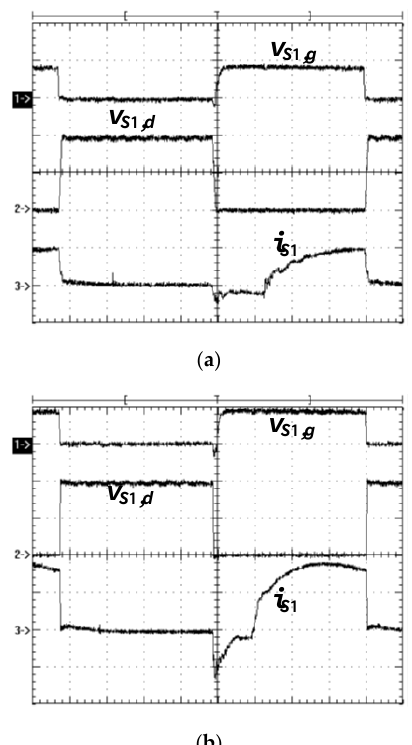
Figure 12. Measured waveforms of the leading-leg switch S 1 at 800 V input ( a ) 20% load (v S1,g : 10 V / div; v S1,d : 200 V / div; i S1 : 1 A / div; time: 2 µ s / div) and ( b ) full load (v S1,g : 10 V / div; v S1,d : 200 V / div; i S1 : 2 A / div; time: 2 µ s / div).